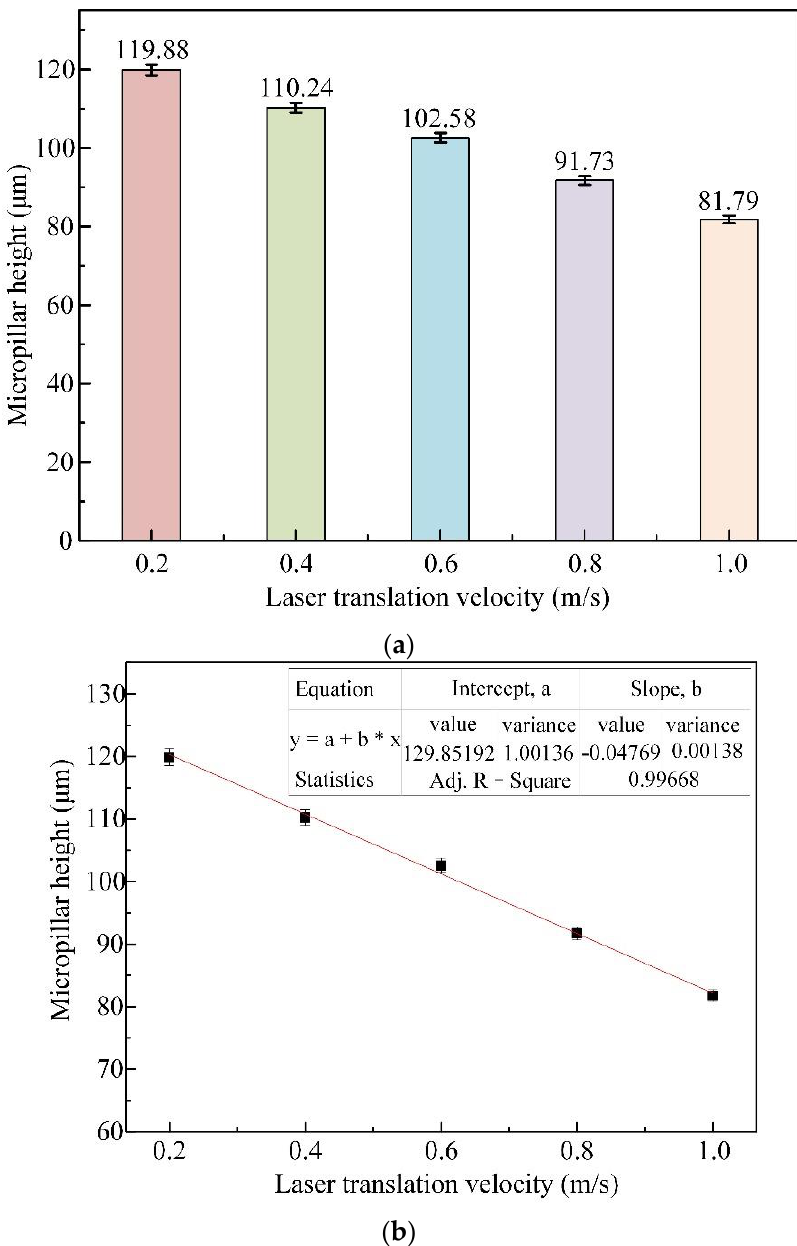
Figure 9. Influence of laser translation velocities on the mean height of micropillars, with a pulse energy of 50 μJ and a pulsed repetition rate of 600 kHz. ( a ) Measurements of micropillar height against laser translation velocity. ( b ) Linear fitting of micropillar height against laser translation velocity.